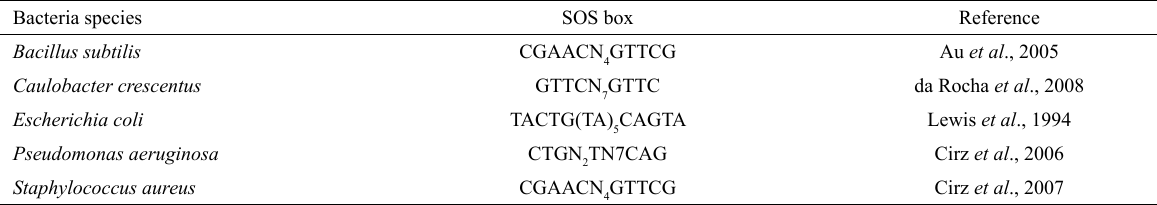
Table 1 – Sequence of the SOS operator (SOS box) in different bacterial